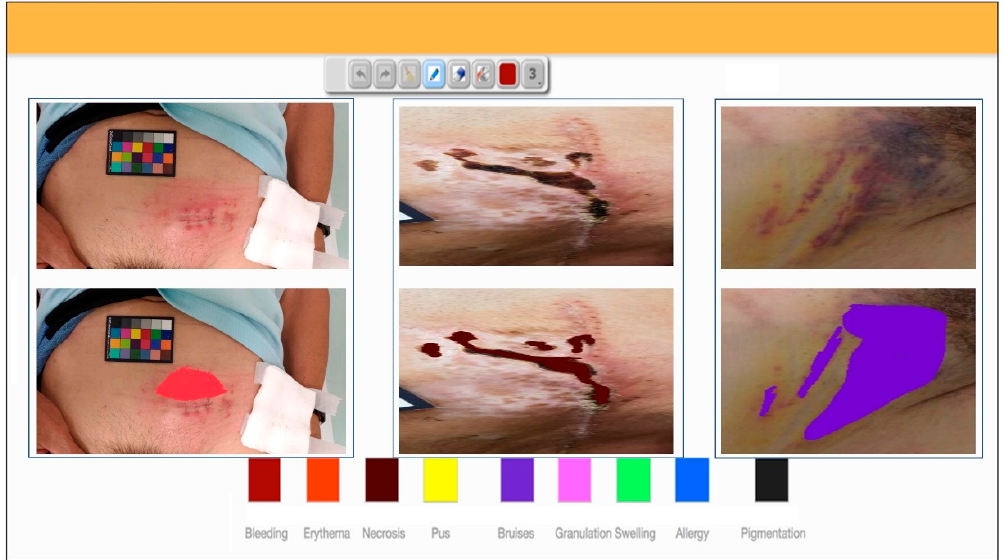
Figure 2. Annotation page for abnormal wound features. The images with abnormal wound features before and after annotation were shown (left: erythema; middle: necrosis; right: bruises).